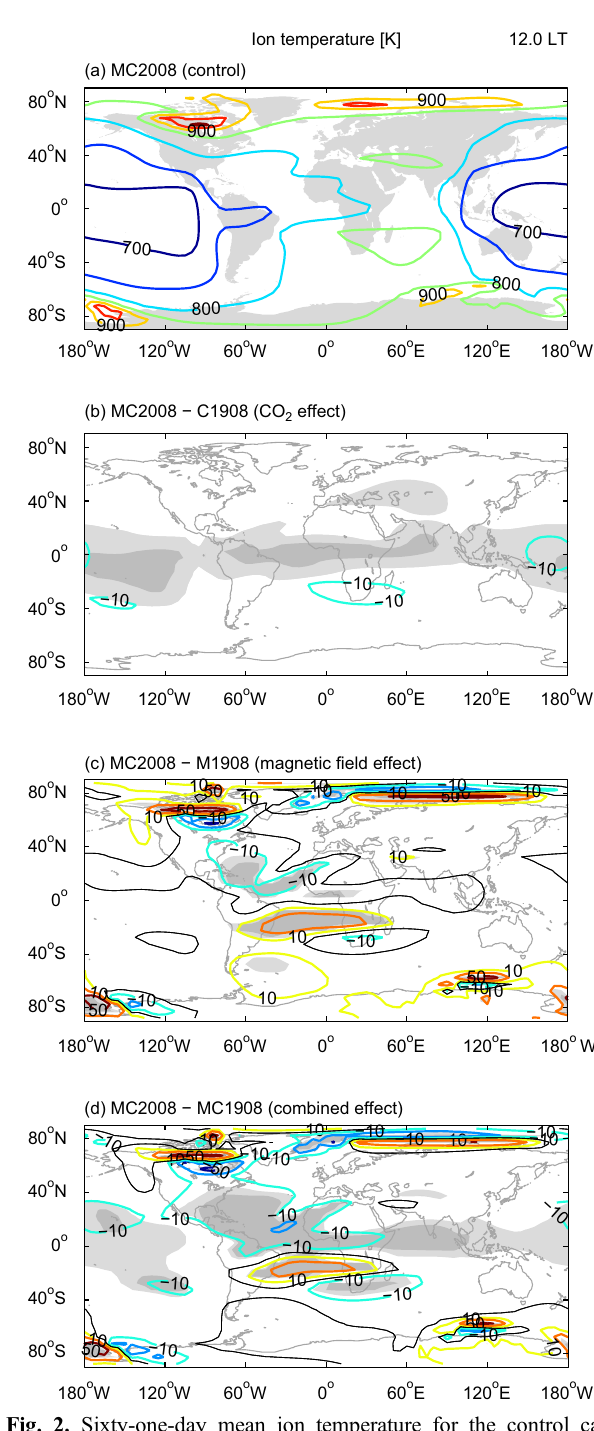
Fig. 2. Sixty-one-day mean ion temperature for the control case (MC2008; panel a) and the difference with C1908, M1908, and MC1908 (panels b–d) at 12 LT at a pressure level of 3.2 · 10 (cid:2) 8 hPa (~300 km). Contours for the difference plots are at 0, ±10, ±25, ±50, and ±100 K. Light (dark) shading indicates statistical significance at the 95% (99%)